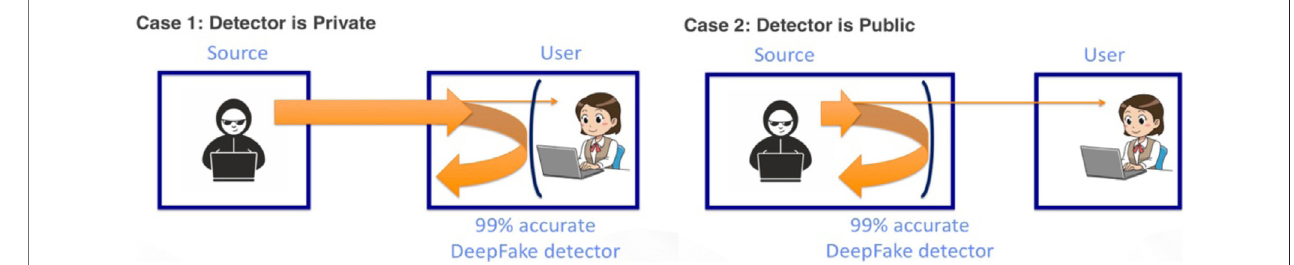
FIGURE 7 | Two different scenarios for the deployment of manipulation fi lters. Left: the assumed scenario is that the user has a 99% accurate detector that fi lters out almost all manipulated content. Right: in a realistic scenario, the source of the misinformation has access to the same detector. Consequently, only manipulated content that passes the detector is released to the public, rendering the detector almost useless. Source: Image created by authors from MS ClipArt.